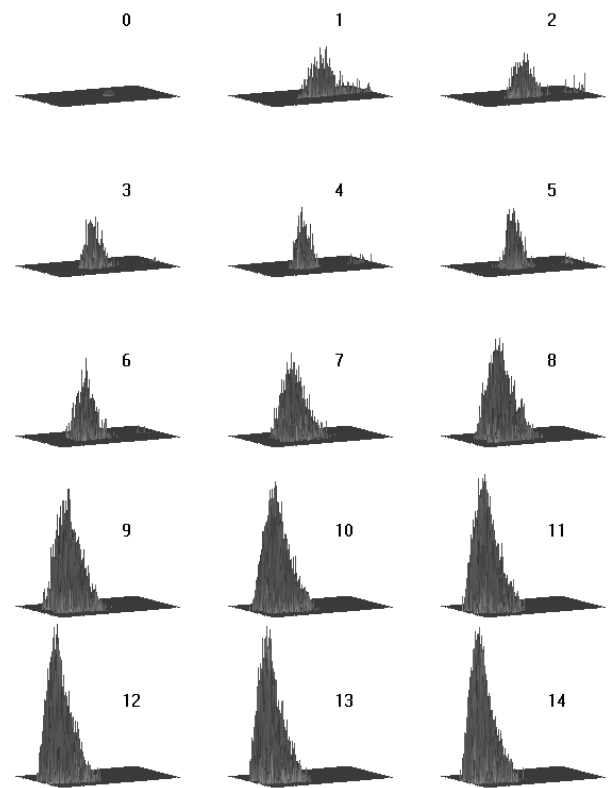
Figure 5. Sequence of 3-D images of lg 10 (S (k,l)) , in which each panel corresponds to a single curve in Fig. 3. The left side refers to the wave number l (cid:0) − M y ≤ l ≤ M y (cid:1) and the front side refers to k( 0 ≤ k ≤ M) . The numbers indicate the end of the time interval expressed in hundreds of nondimensional time units.